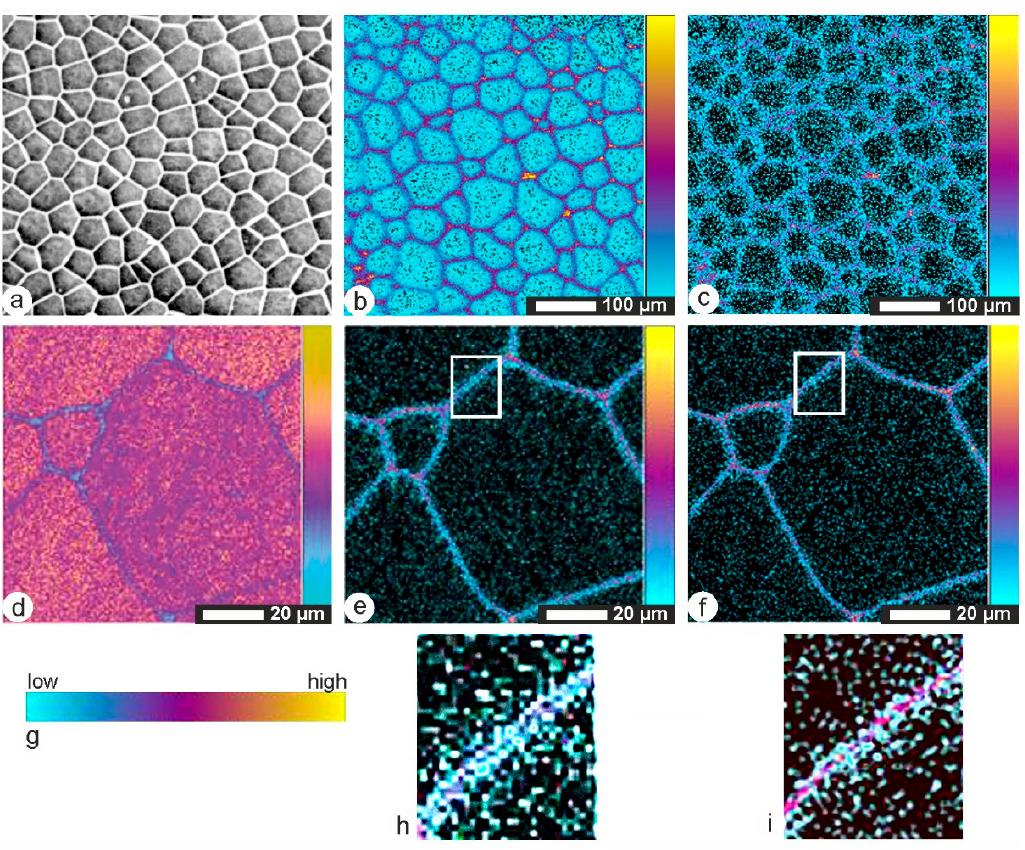
Figure 9. Time-of-flight secondary ion mass spectrometry (TOF-SIMS) maps of transverse sections of Pinna prismatic layer. ( a ) Scanning electron microscope (SEM) image showing the polygonal shape of prisms. ( b ) Glycine map, showing the high content of the inter-prismatic membranes. ( c ) Phenyl-alanine map. ( d ) Ca map, showing that the intra-prismatic zone is not homogeneous. ( e , h ) Maps showing the heterogeneous distribution of proline in the inter-prismatic membrane. ( f , i ) Detailed maps showing the irregular content of glycine in the inter-prismatic membrane. ( g ) Color scale.